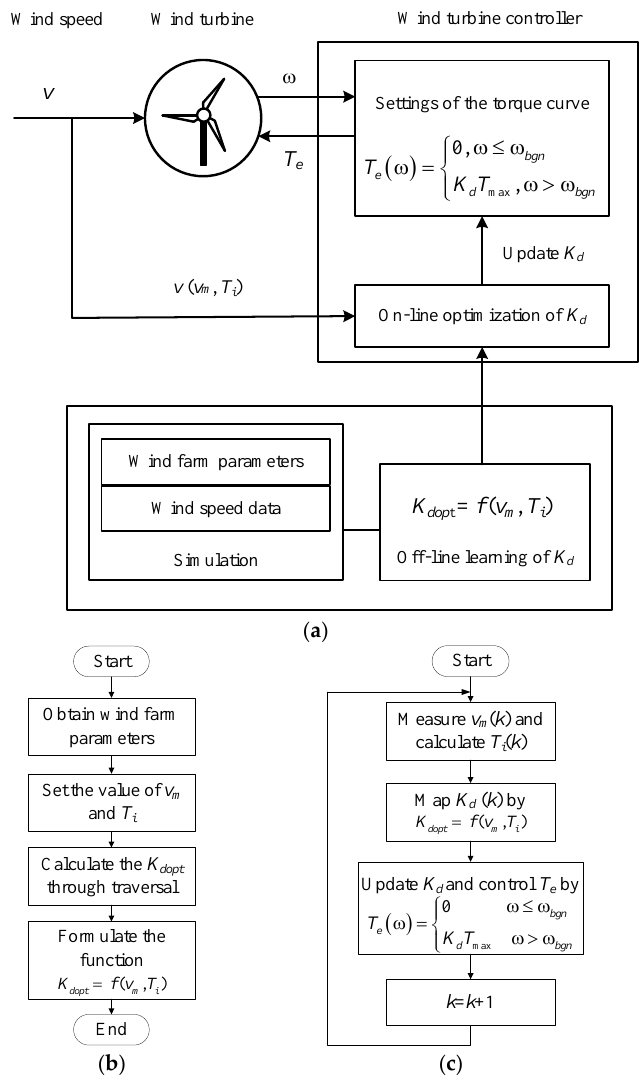
Figure 7. IATG (improved adaptive torque gain) control: ( a ) schematic diagram; ( b ) flow diagram of off-line learning; and ( c ) flow diagram of on-line optimization.